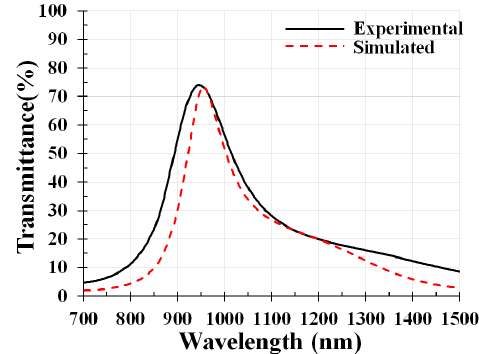
Figure 5. Transmittance spectra of designed and deposited experimental multilayers, air/a-Si/Ag/a-Si/Ag/glass.